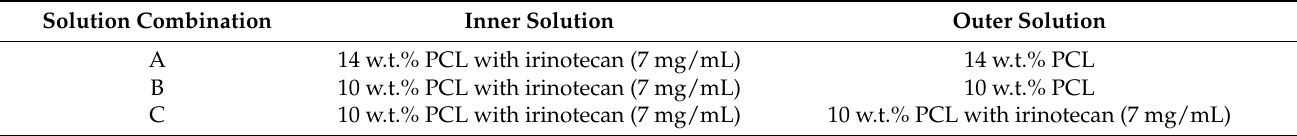
Table 1. Solutions used in the different coaxial electrospinning processes.